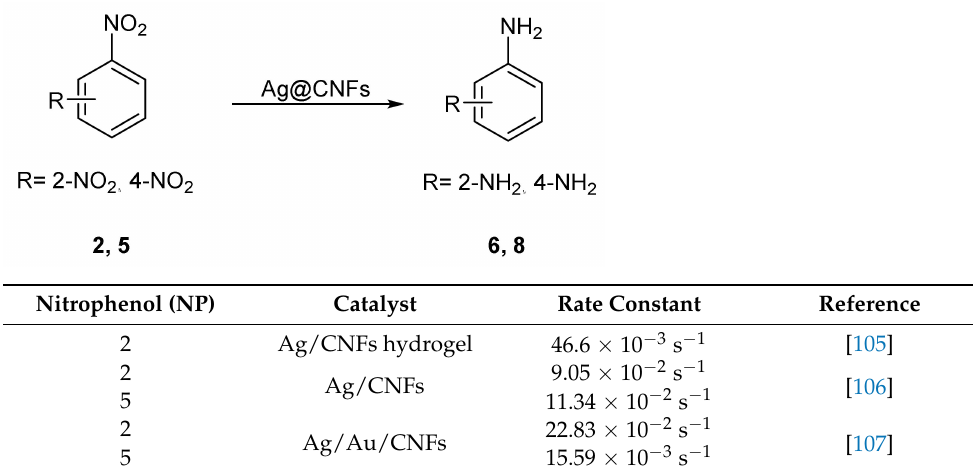
Table 11. Applications of Ag NPs@CNFs catalysts to 4-NP 2 and 2-NP 5 reduction in